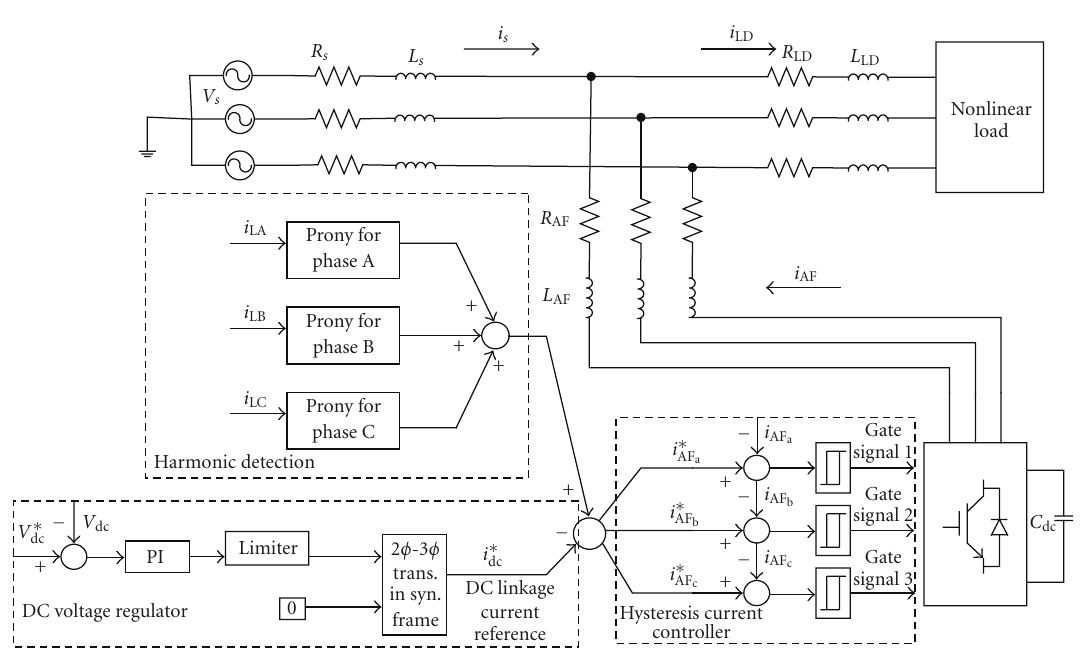
Figure 2: Configuration of test system